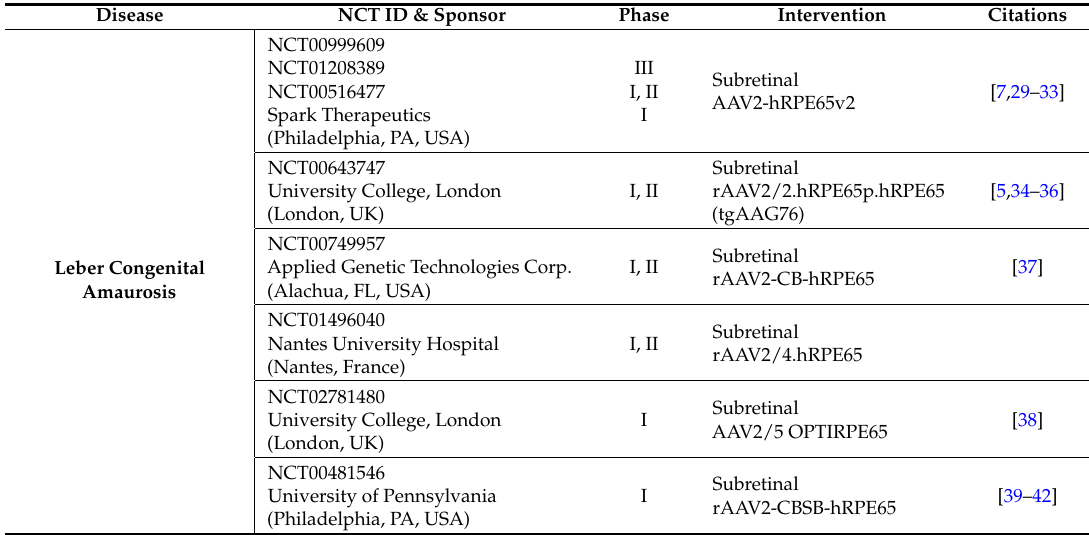
Table 1. Gene therapy trials for retinal diseases, with relevant articles